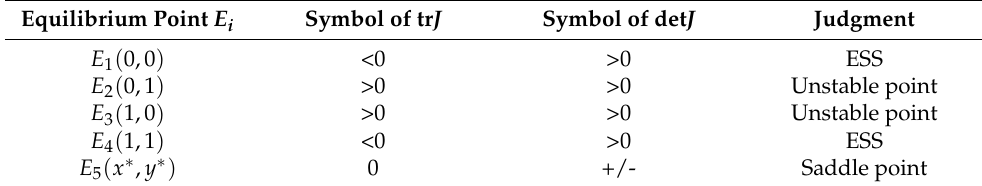
Table 4. The analysis of the evolutionary stability of the system equilibrium point.